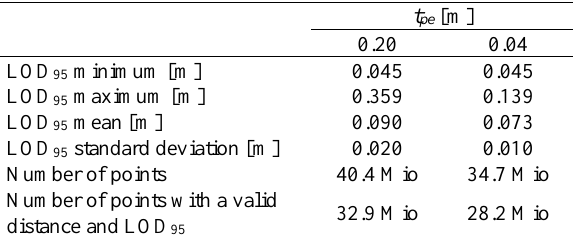
Table 1. Level of detection and number of points in the rectangular test site subset for two different point error thresholds t pe .